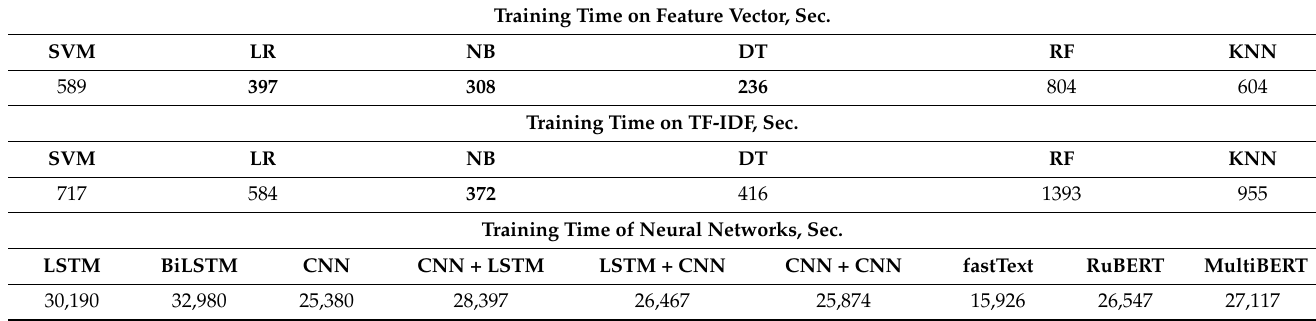
Table 10. Training time on the dataset of 50